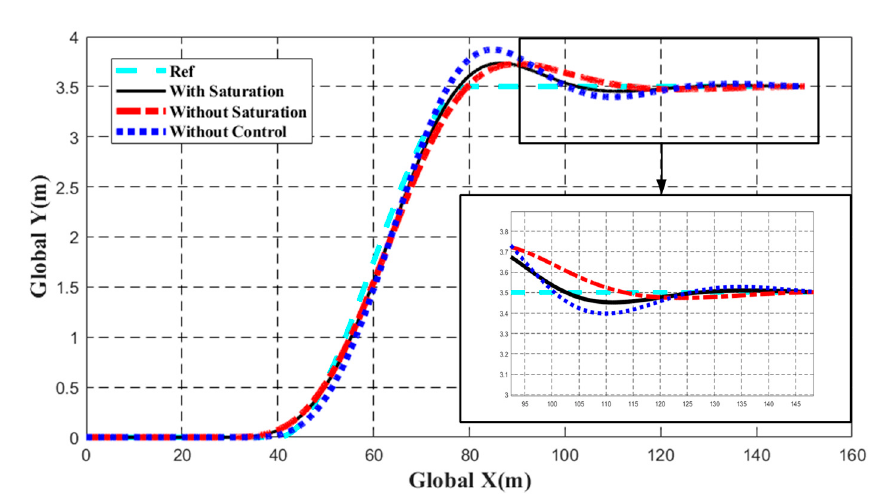
Figure 3. The simulation results for the global trajectories.